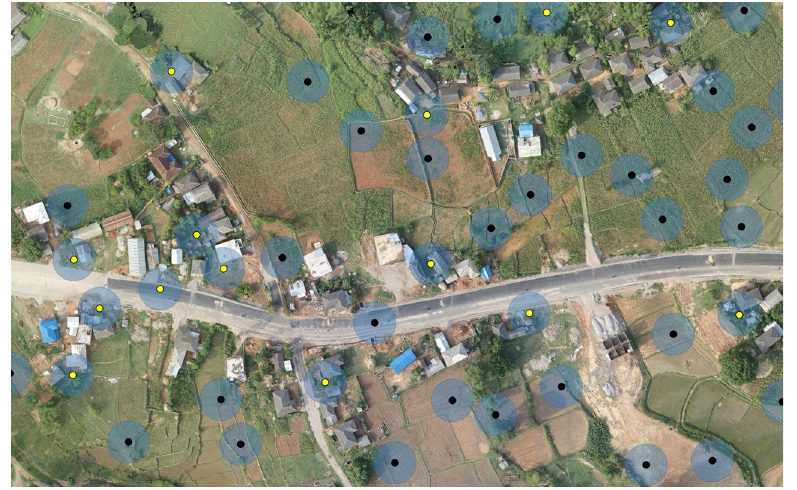
Fig 1. Example of household selection using random points and 10 m-radius buffer area. The yellow dots exemplify the selected households. The size of the dots has been increased for clarity. Sample image from http:// openaerialmap.org with similar viewpoint to the ones used in the methodology (licenced CC BY 4.0).